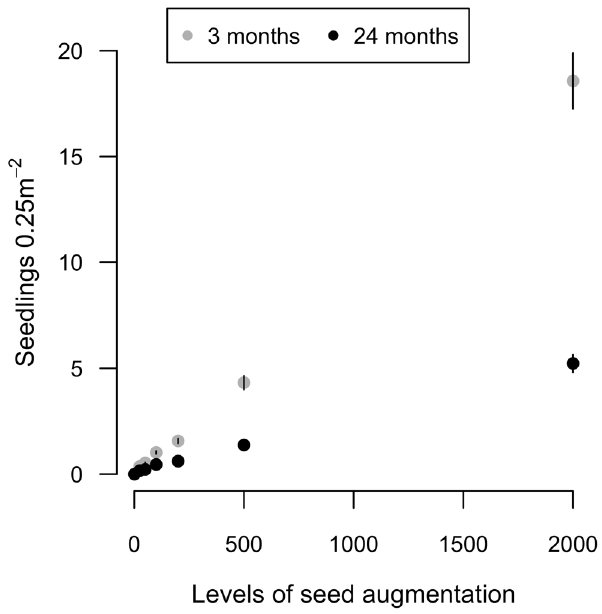
Figure 4. Density of seedlings as a function of seed augmen- tation level. The densities of seedlings are averaged over 5 species ( Pancovia laurentii, Staudtia kamerunensis, Manilkara mabokeensis, Myrianthus arboreus, and Entandophragma utile) , as a function of levels of seed augmentation, for the first three months and 24 months of seedling growth. Error bars are 95% confidence intervals. Weak seed limitation observed in Fig. 1a results in a gradual, but significant increase in total seedling numbers at very high seed